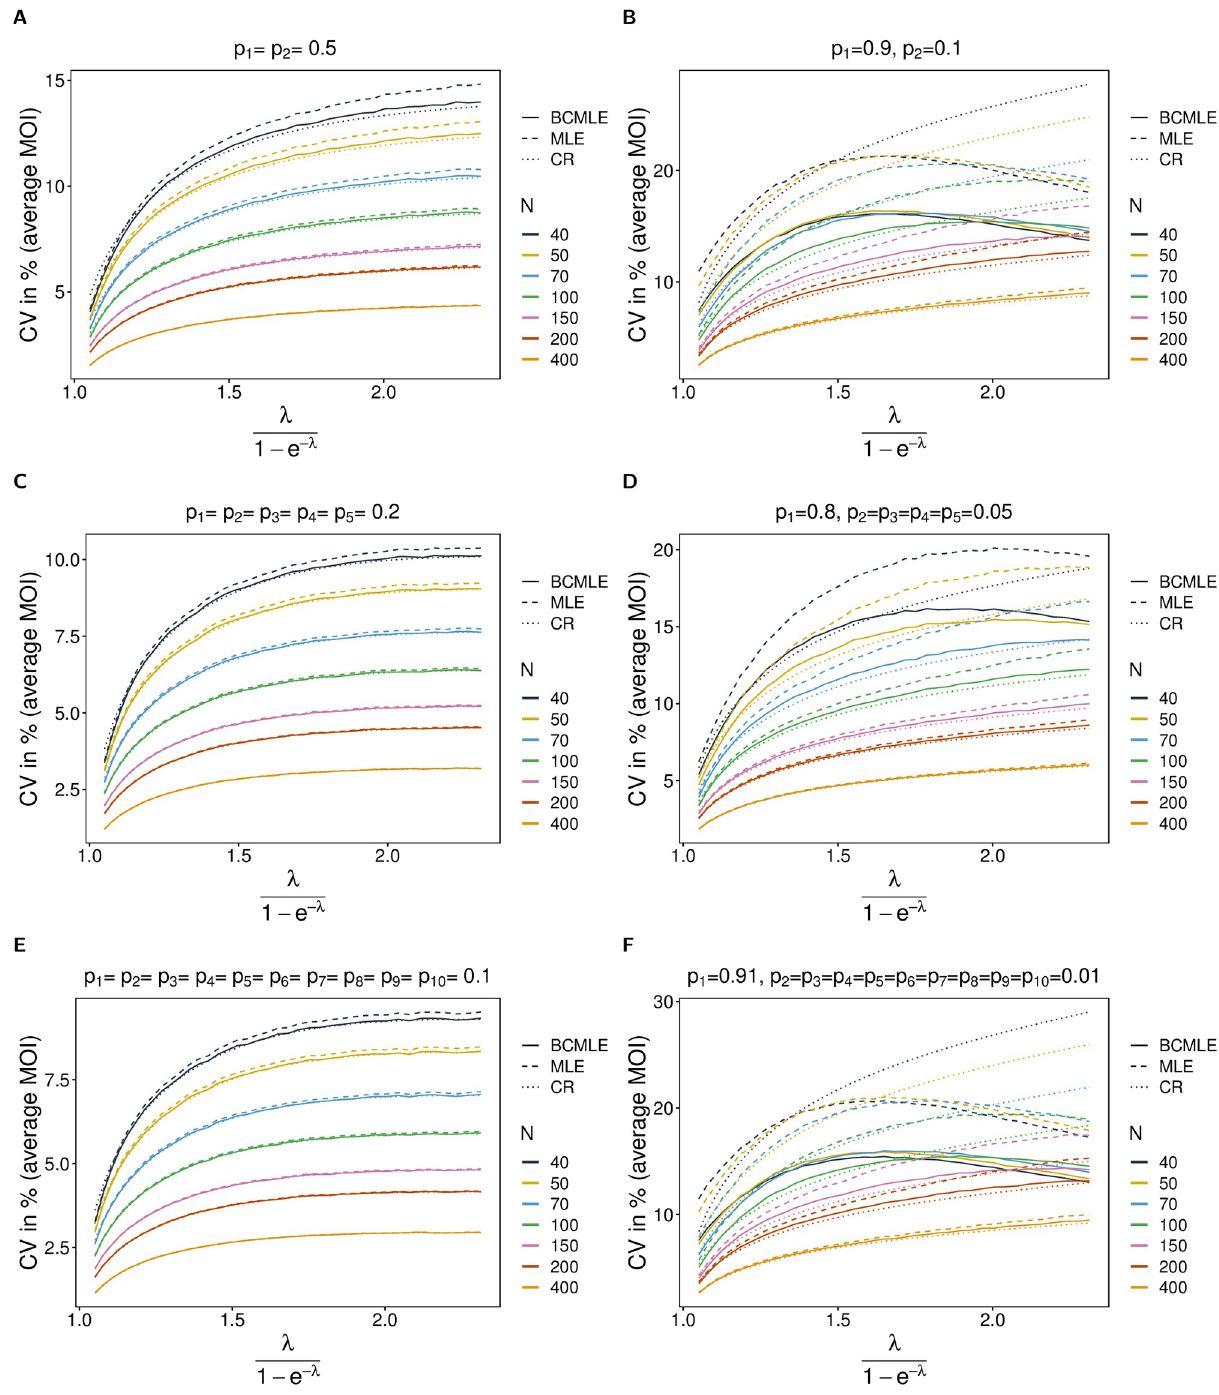
Fig 3. Variance of MOI estimates. Similar to Fig 2 but for the coefficient of variation in %. The dotted lines are the respective predictions based on the Crame´r-Rao lower bounds.